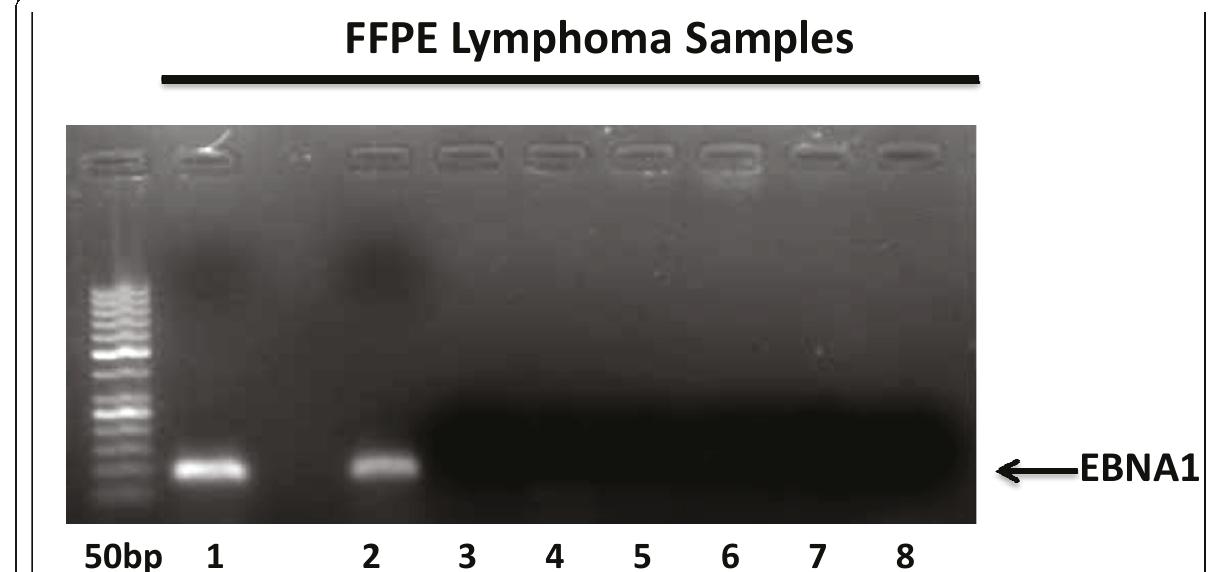
Figure 1 Results of agarose Gel Electrophoresis of EBNA 1 genomic DNA (left-to-right) : Lane 1 shows the 50 bp DNA ladder, Lane 2-3 represents the EBNA1 positive Burkitt ’ s lymphoma samples (100 bp Nested PCR amplified product), Lane 4 represents EBNA1 Negative Burkitt ’ s